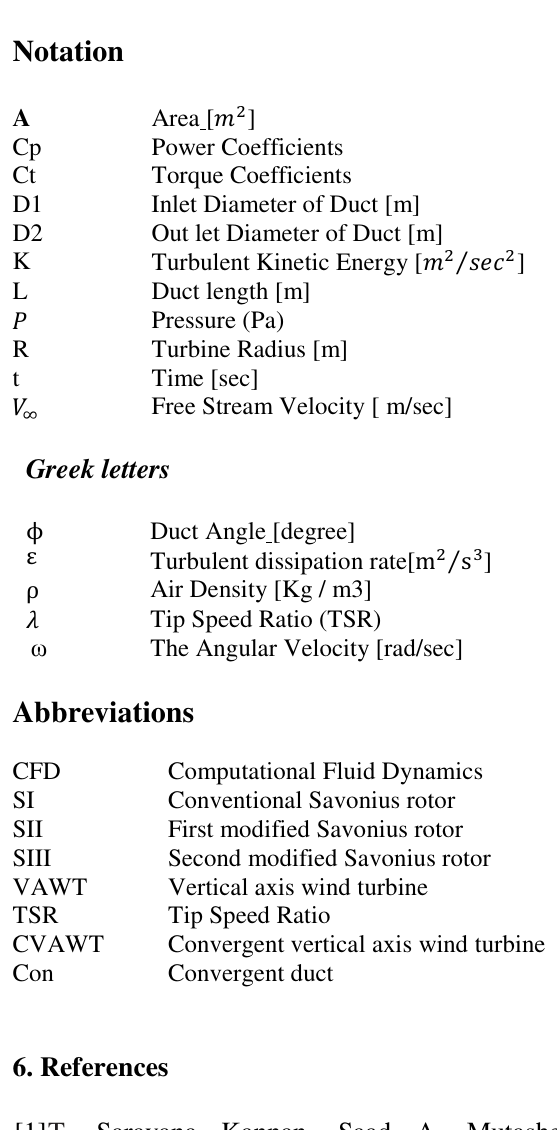
Fig. 14. Power coefficient for convergent duct wind turbine with inlet angle 12 °